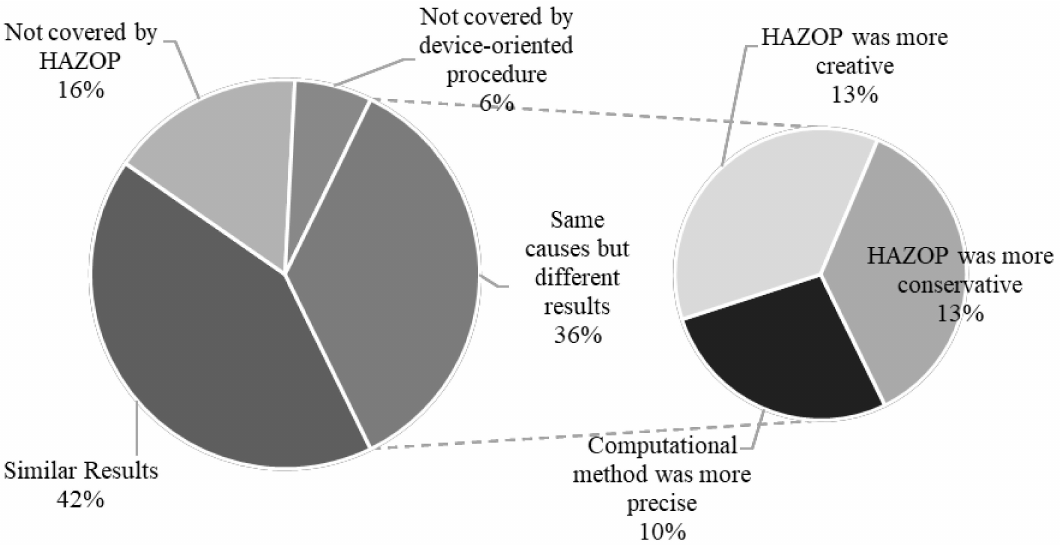
Figure 31. Stratified comparison between the standard and the computational-based